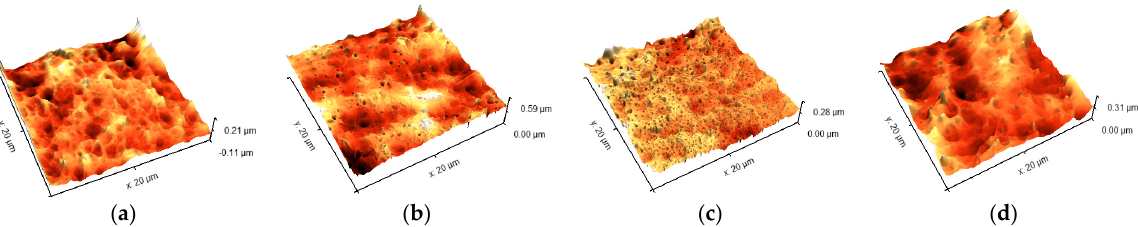
Figure 5. The visualization of the surfaces of the samples before aging for ( a ) unmodified sample and modified samples with ( b ) MFSC 1; ( c ) MFSC 4; ( d ) MFSC 5.